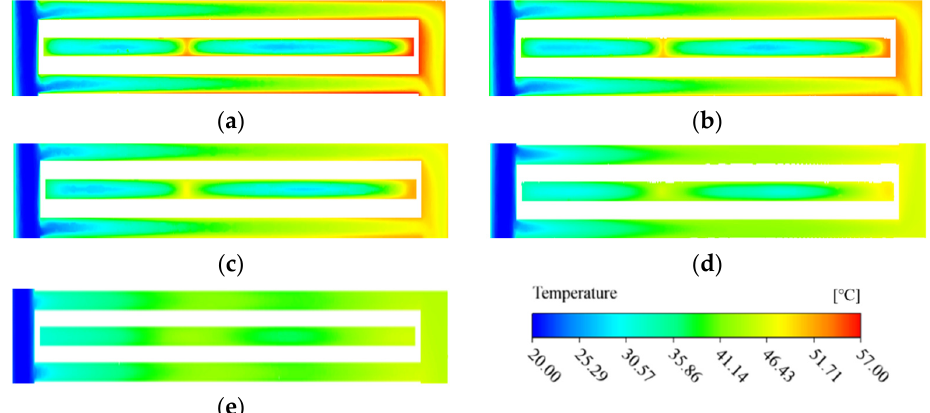
Figure 14. The temperature distribution of microchannel region at different microchannel number.